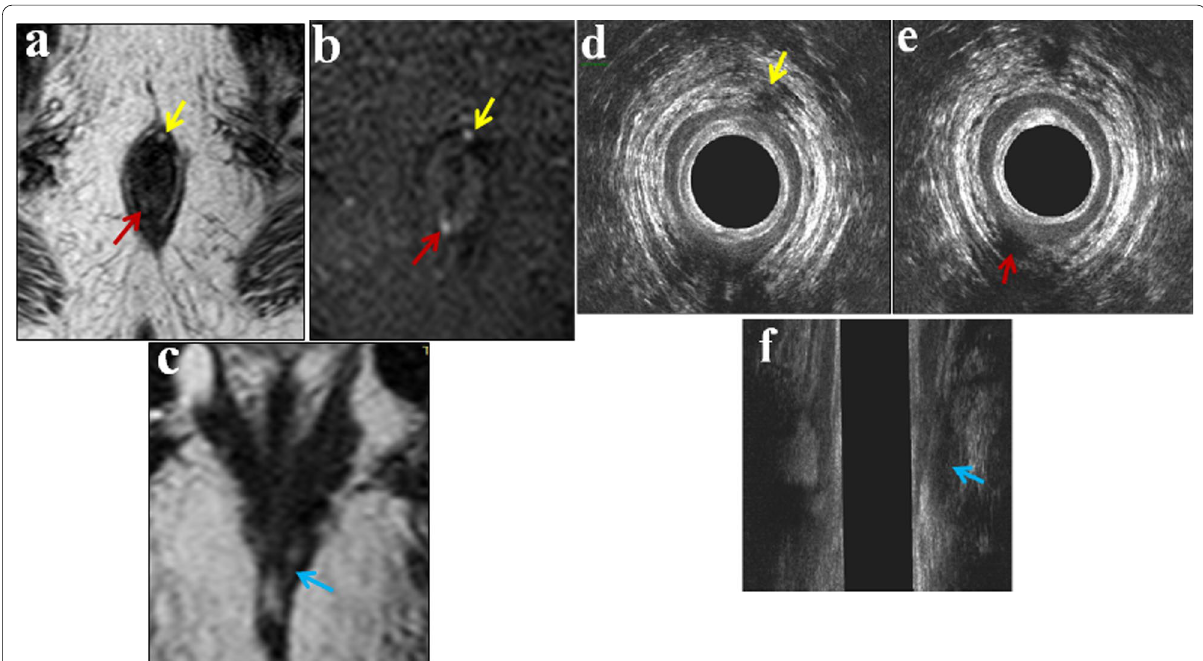
Fig. 1 a , b MRI axial T2 and STIR WI images showing two fluid filled intersphincteric fistulous tracts eliciting high signal and abutting the internal sphincter at 1 o’clock (yellow arrows) and 6–7 o’clock (red arrows). c Coronal T2 MRI WI images showing left intersphincteric fluid filled fistulous tract (blue arrow). d Ultrasound images show a hypoechoic fistulous tract seen within the left anterior intersphincteric space abutting the internal anal sphincter (internal opening) opposite 1 o’clock (yellow arrow). e Another hypoechoic fistulous tract seen within the right posterior intersphincteric space abutting the internal sphincter opposite 6–7 o’clock (Red arrow). (f) Ultrasound coronal images show left short intersphincteric fistulous tract breaching the internal sphincter at the level of the superficial portion of the external sphincter (blue